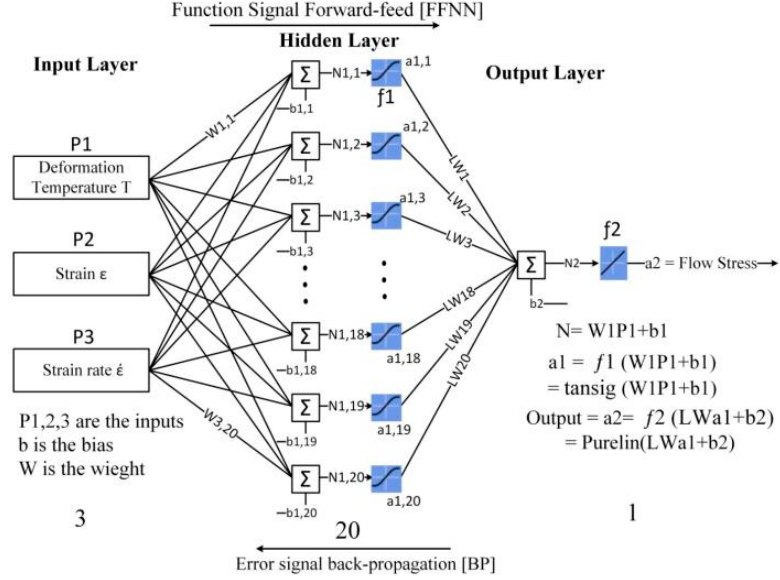
Figure 5. Schematic illustration of the used back-propagation (BP) artificial neural network architecture.